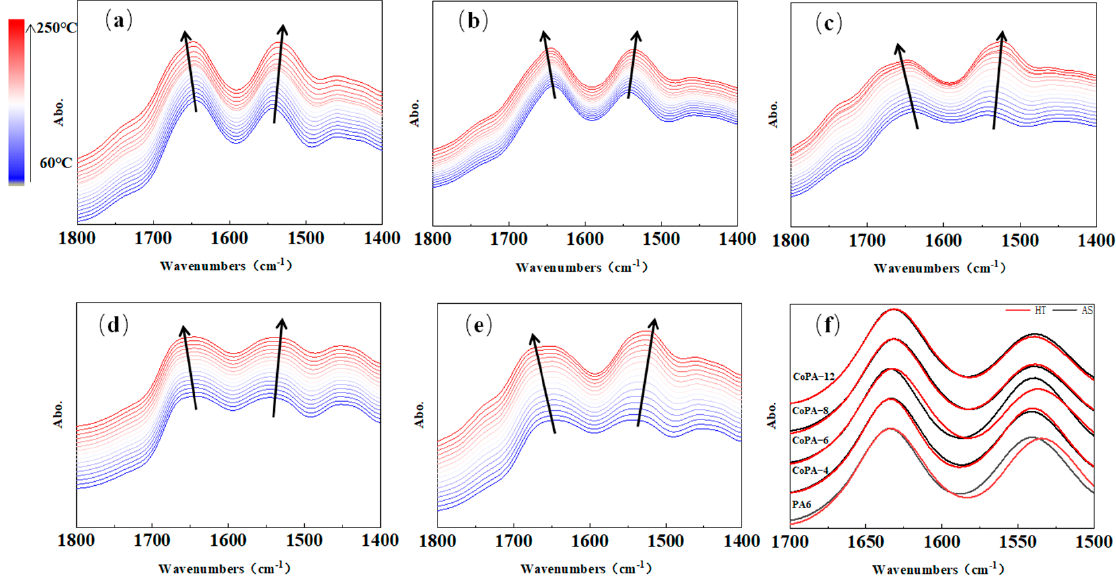
Figure 5. In-site temperature-variable FTIR spectra for polyamide 6 AS fibers ( a ), CoPA-x AS fibers with the x value of 4, 6, 8, and 12, respectively, under the wavenumber varying from 1800 cm − 1 to 1400 cm − 1 ( b – e ), and ATR-FTIR spectra for HTs and ASs of PA6 and CoPAs at 25 ◦ C from 1700 cm − 1 to 1500 cm − 1 ( f ).